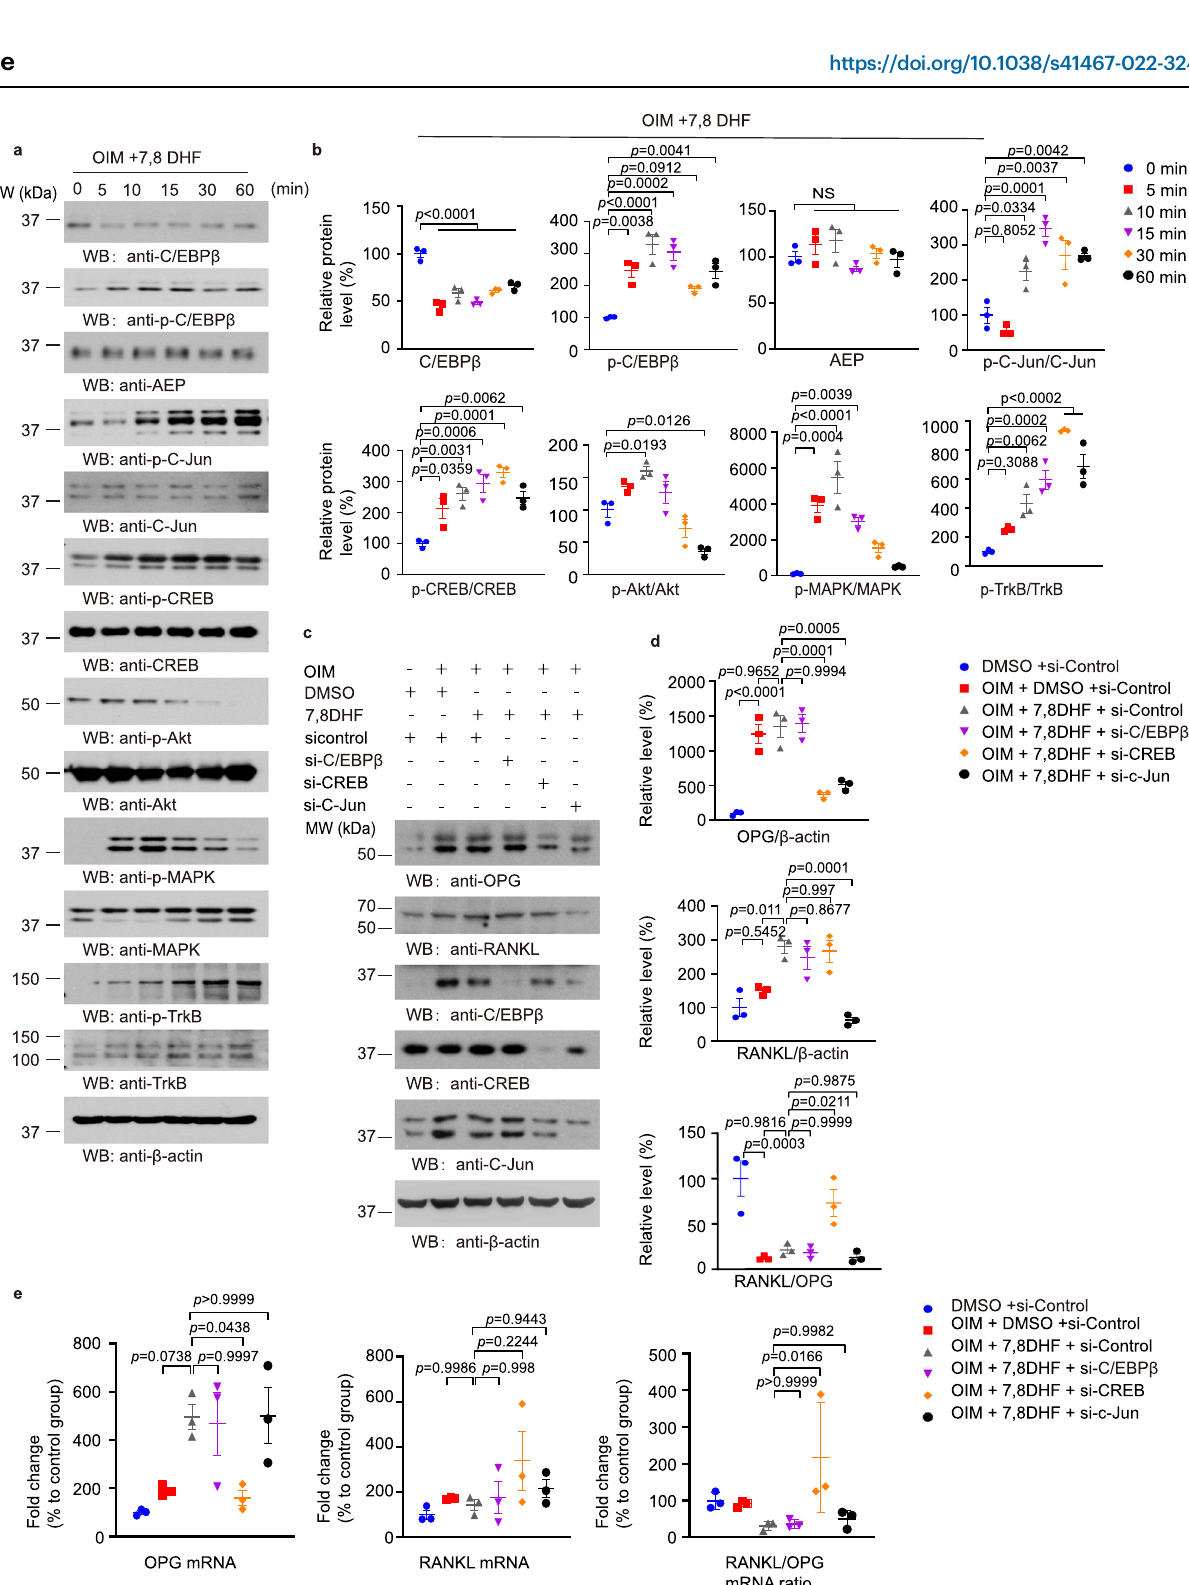
independent experiments, one-way ANOVA. c Western blotting showed that knockdown of CREB blunted 7,8-DHF-induced OPG expression. d Relative protein levelsofRANKL,OPG,andRANKL/OPGratio.Dataareshownasmean±SEMofthree independentexperiments,one-wayANOVA. e qPCRresultsshowedthatknockdown of CREB inhibited OPG mRNA expression induced by 7,8-DHF. Data are shown as mean±SEM of three